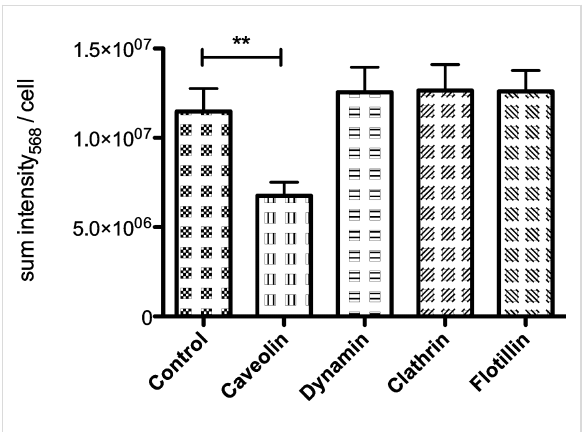
Figure 8: Sum-fluorescence-intensity (wavelength 568) per cell of SCIONs labeled with Alexa Fluor ® 555 in transfected HeLa cells after 4 h incubation time; target proteins: Caveolin-1, Dynamin 2, Flotillin-1, Clathrin (iron concentration 5 µg/mL, n = 4).